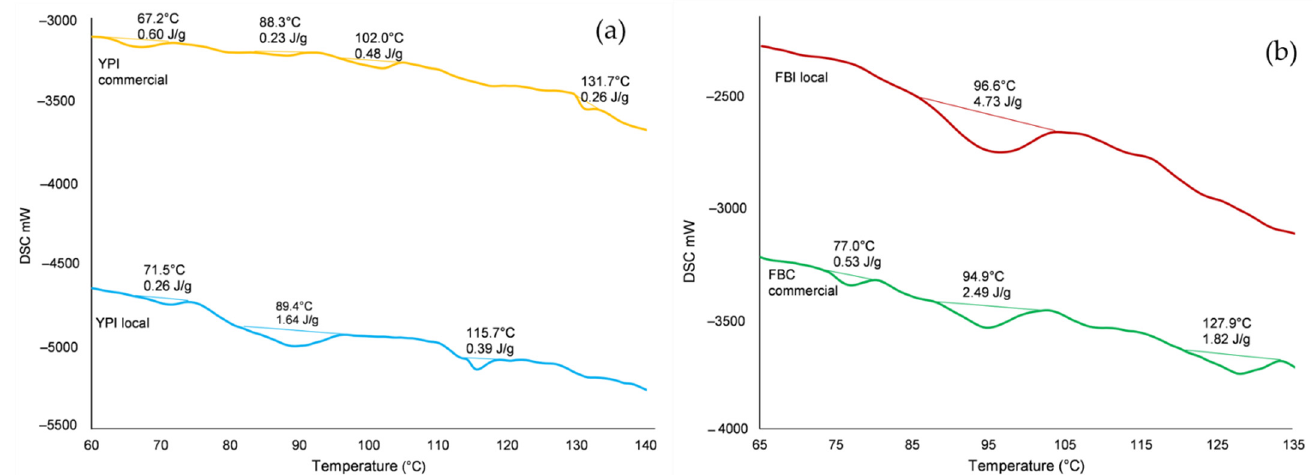
Figure A2. Denaturation temperature and enthalpy of ( a ) yellow pea isolate and ( b ) faba bean isolate.